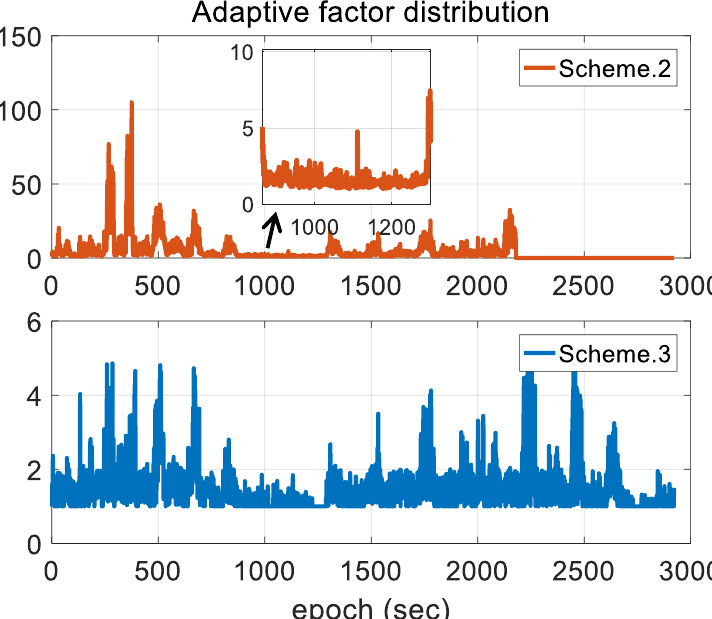
Figure 14. Comparison of adaptive factor distribution.